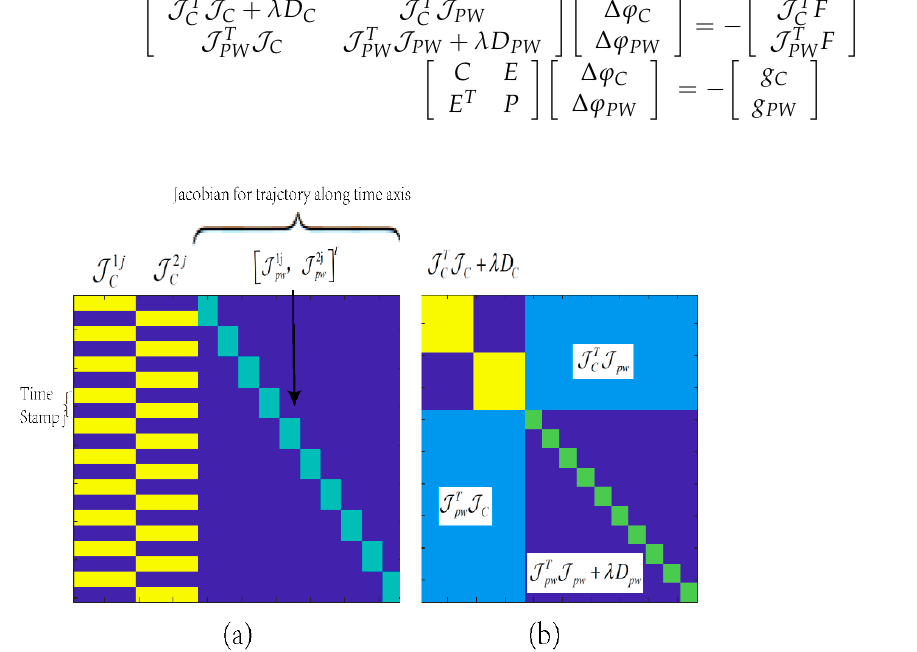
Figure 2. ( a ) Jacobian matrix for stereo high frame-rate (HFR) cameras; ( b ) related Hessian Matrix of these two HFR cameras.